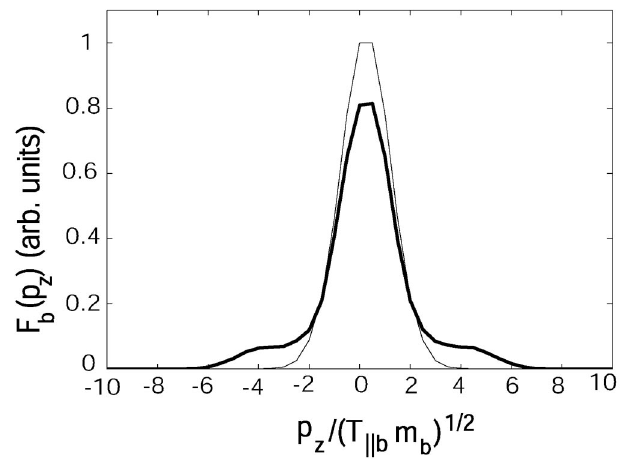
for the onset of the electro- b